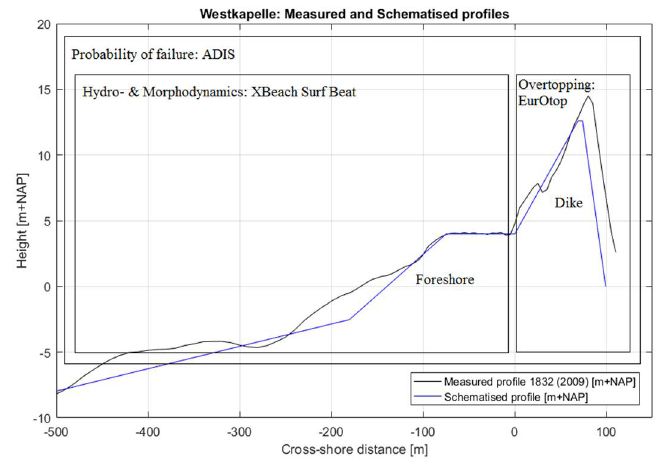
Figure 2 . Measured 2009 bathymetric transect 1832 of the Westkapelle dike-foreshore system (black) and the profile used for the calculations (blue), with the models that were used in the model framework and the processes which they model. Note that only the section from −500 m to 150 m is shown.